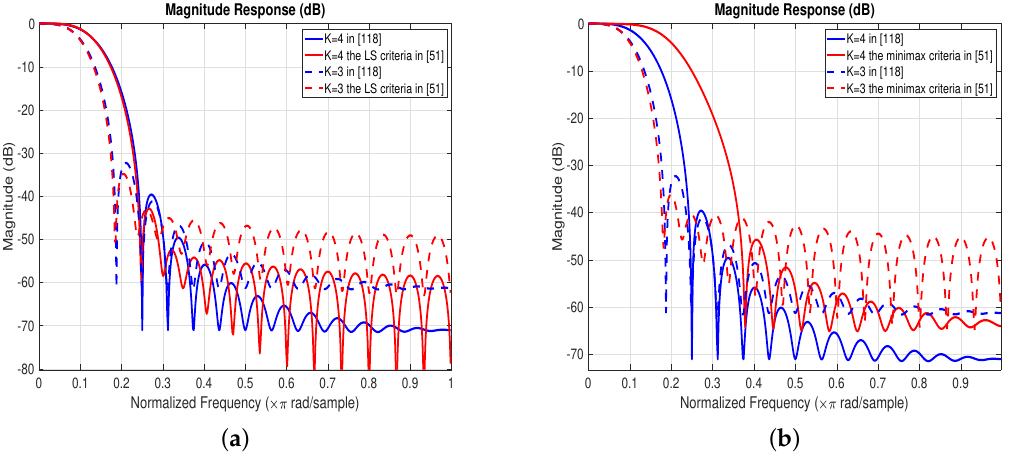
Figure 1. ( a ) Frequency responses of prototype filters implemented based on the least squares (LS) criterion in [51] and the method in [118] (K = 3 and K = 4). ( b ) Frequency responses of prototype filters based on the minimax criterion in [51] and the method in [118] (K = 3 and K =